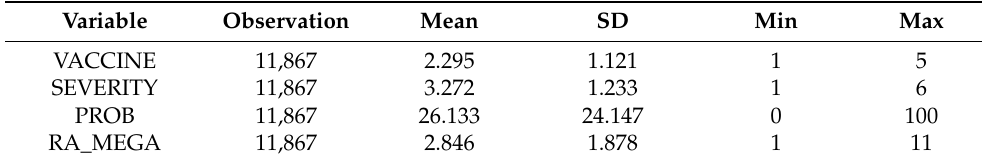
Table 2. Descriptive statistics of the variables used in this paper: All waves.